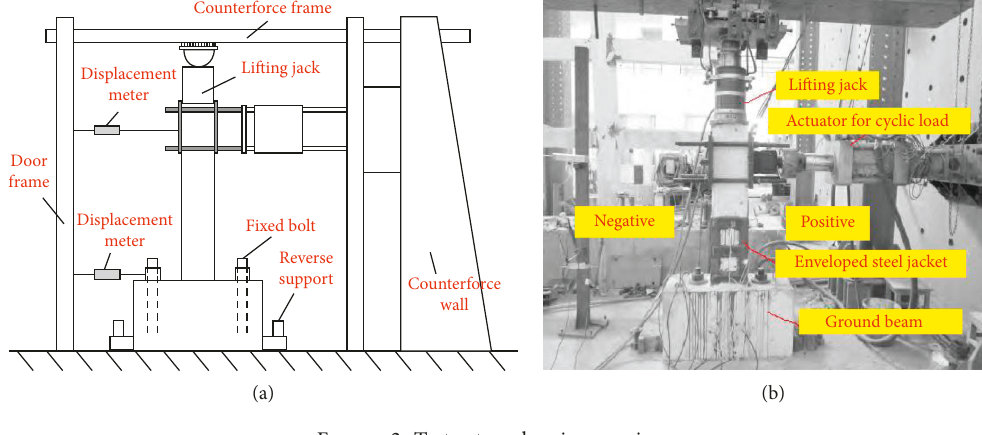
Figure 2: Test setup showing specimens.